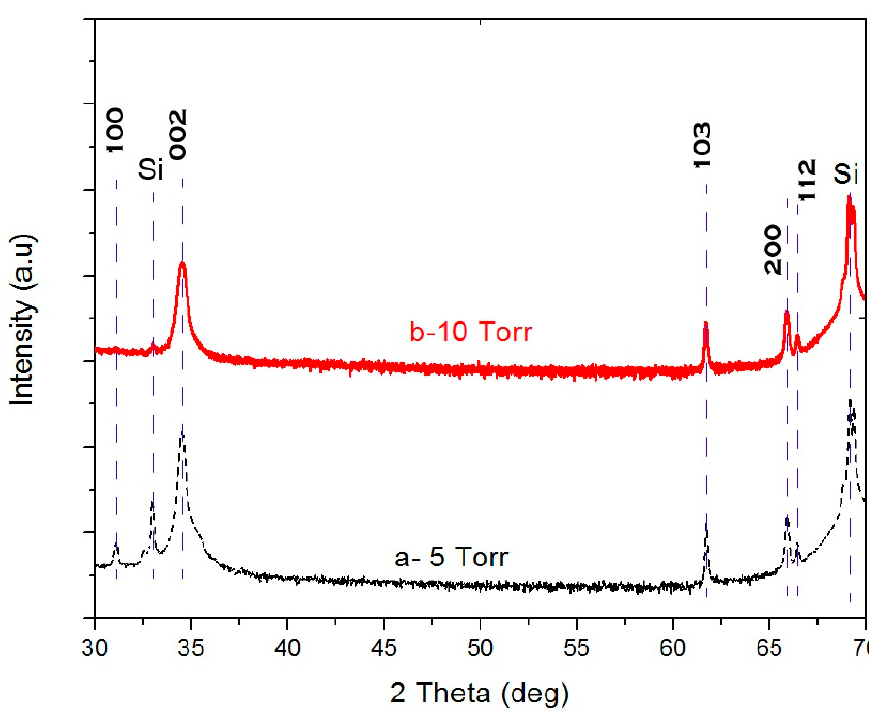
Figure 7. XRD pattern 2 θ scan of ZnO NWs grown on ZnO SL at Tsub = 380 °C and argon pressure at ( a ) 5 Torr and ( b ) 10 Torr.